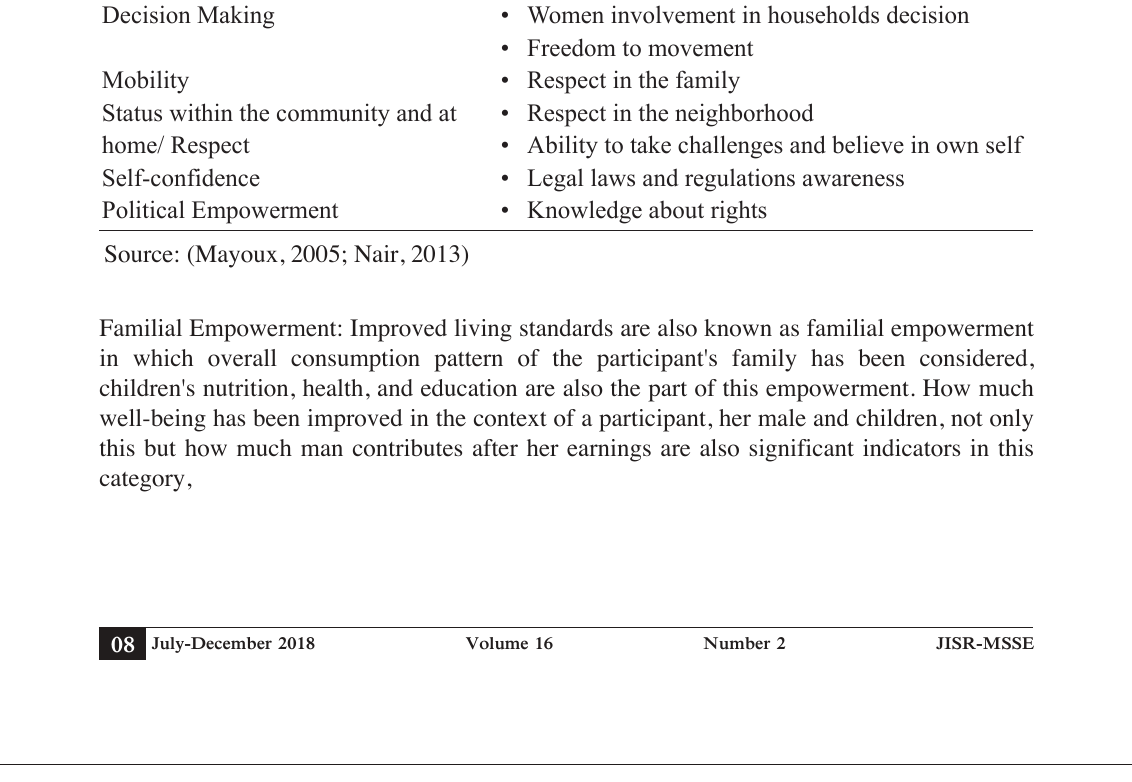
Indicators for Women Social and Political Empowerment